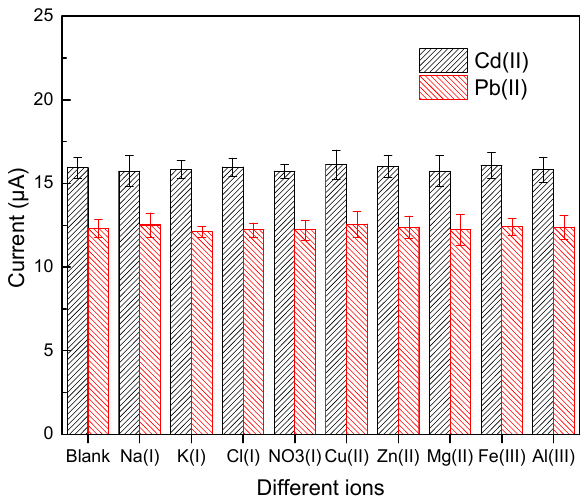
Figure 7. The selectivity of the Bi / LC-rGO / DSPE measured with 25 µ g / L of Cd(II) and Pb(II) by adding 10-fold coexisting ions.